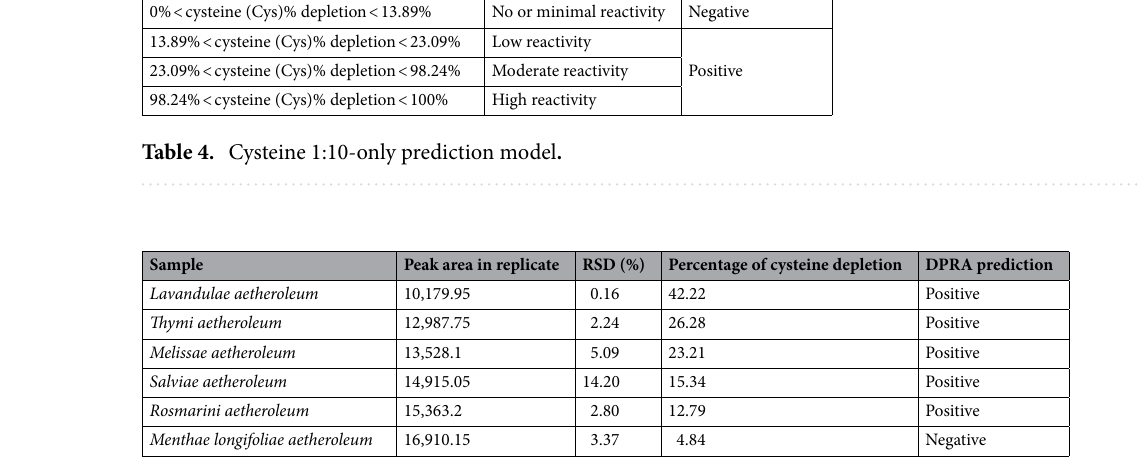
Table 5. Percent cysteine depletion in each sample replicates